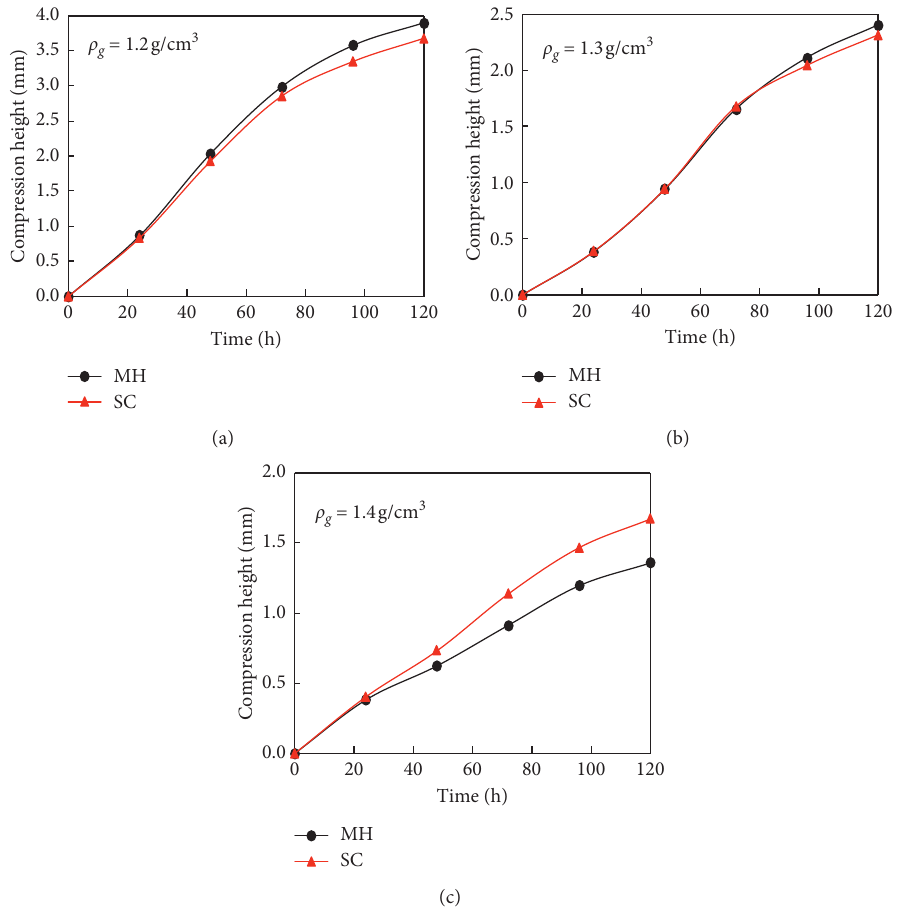
� 1 . 2 g /cm 3 . (b) ρ � 1 . 3 g /cm 3 . g g